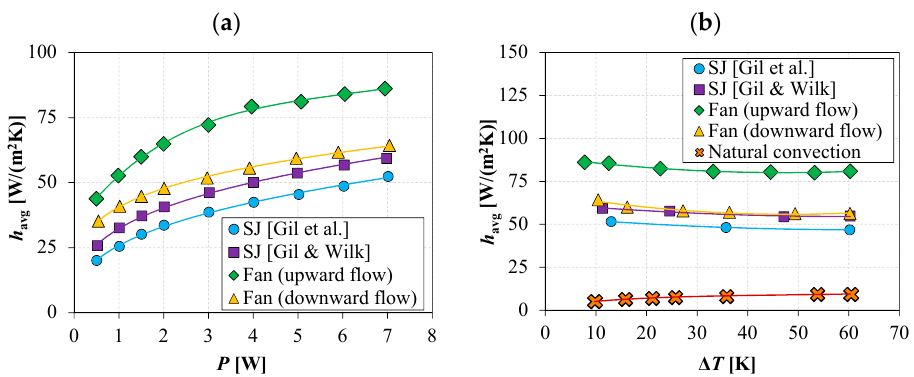
Figure 8. The average heat transfer coefficient as a function of ( a ) the power supplied to the cooling device; ( b ) temperature difference ∆ T = ( T b − T ∞ ) at the power of P = 7.0 W. Data from: Gil et al. [27], Gil and Wilk [28].